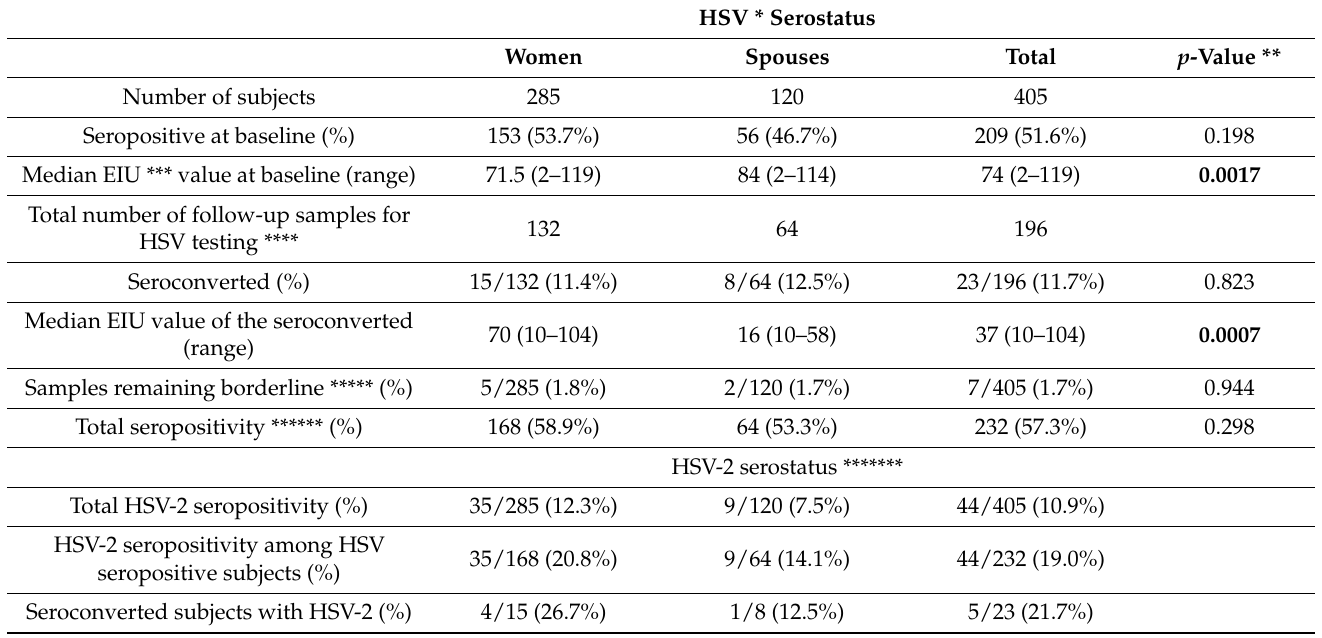
Table 1. Herpes simplex virus (HSV) serology of the women and their spouses at baseline and at the end of